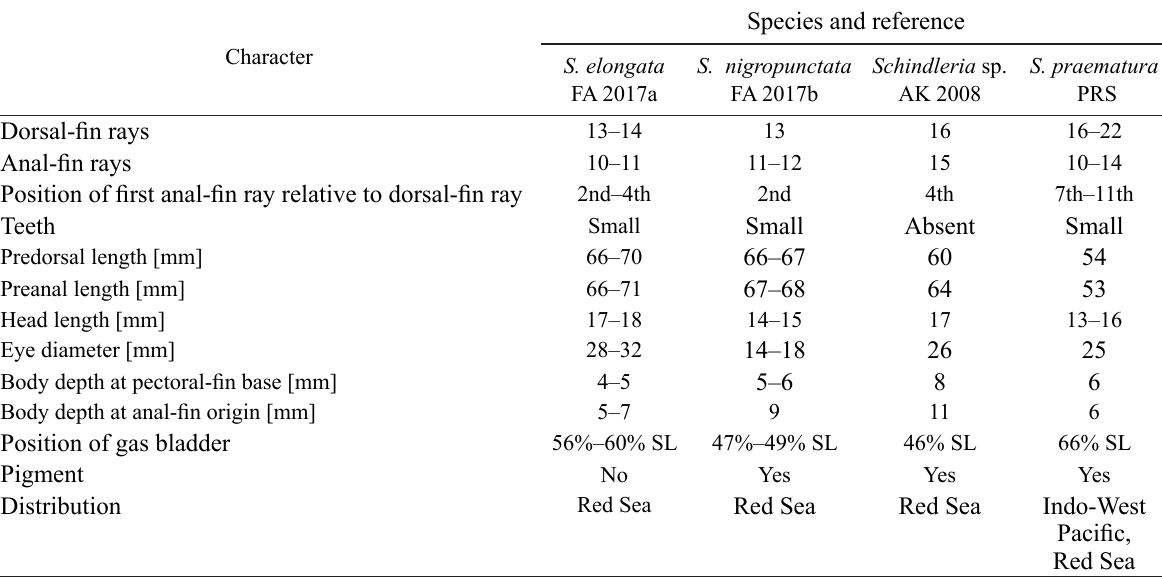
Comparison between Schindleria praematura and other Schindleria species in the Red